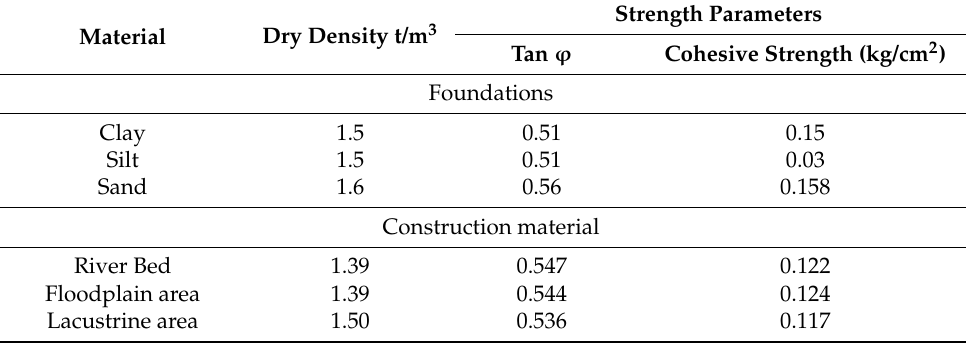
Table 2. Cases used in the investigation process.